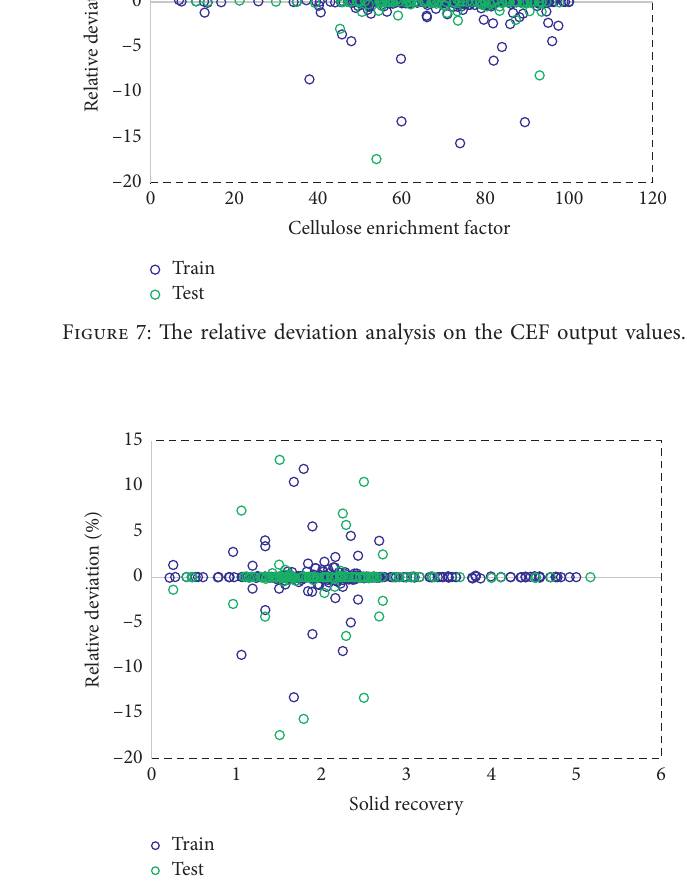
Figure 8: The relative deviation analysis on the SR output values.